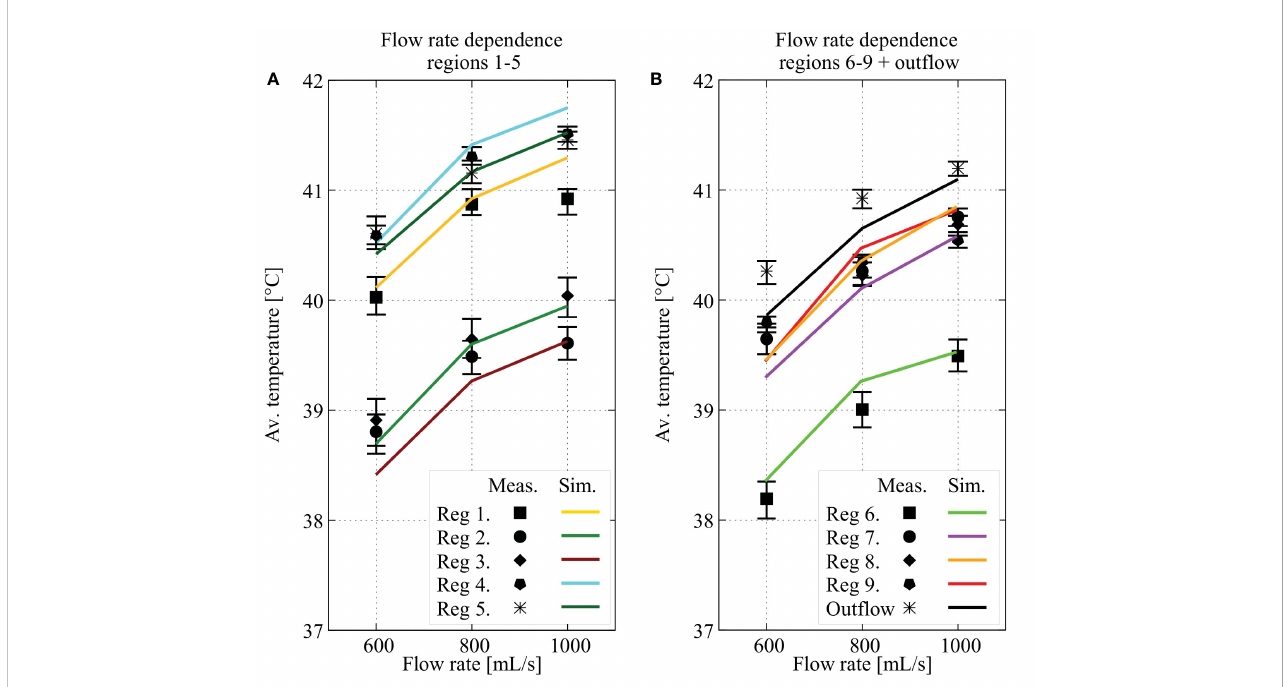
FIGURE 6 Effect of the fl ow rate on the temperature in each region and on the out fl ow temperature. In fi gure (A, B) , average values for region 1 through 5 and 6 through 9 plus out fl ow are plotted for three different fl ow rates (600, 800 and 1000 mL/min),respectively. The values shown are calculated as the average over the last 5 minutes of the predicted (colored line) or measured values (min/max values in that last fi ve minutes shown by the whiskers and the average shown by the symbols). All regions show an increase in treatment temperature after 25 minutes, correctly predicted by simulated pro fi les.